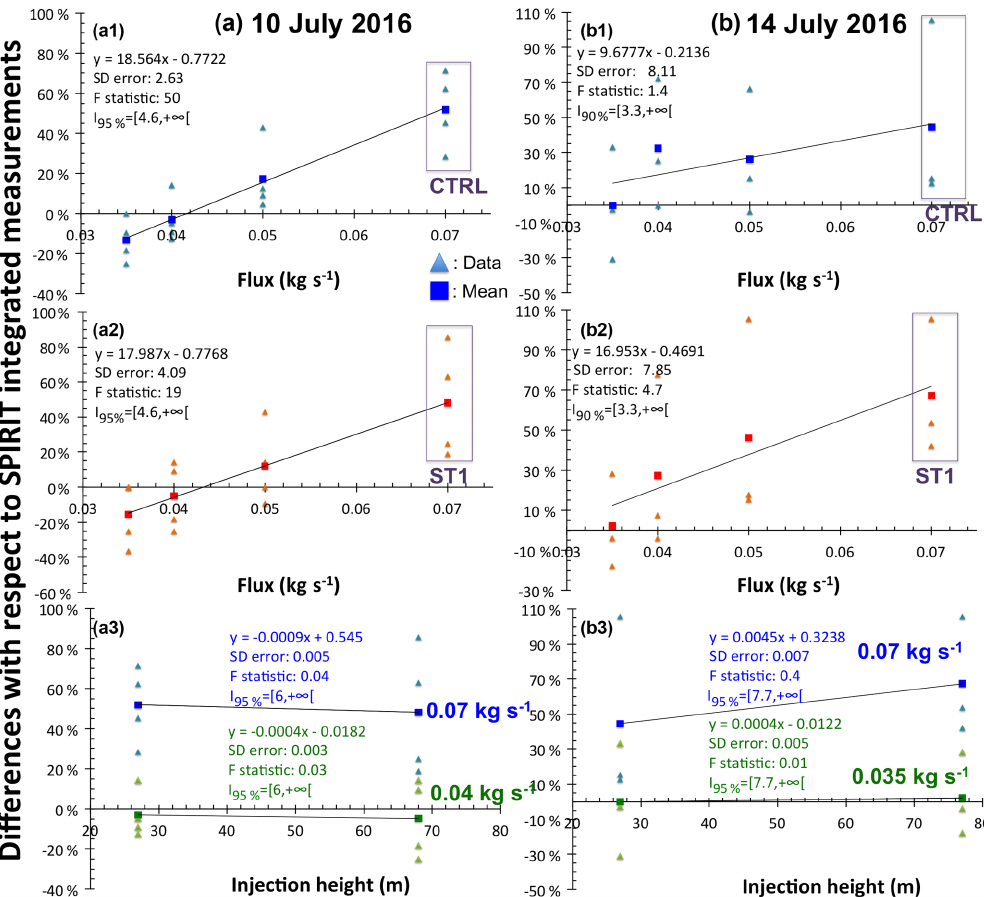
Figure 3. Differences (in %) between FLEXPART simulations and SPIRIT integrated measurements depending on flux or injection height used as input in the model for (a) the flight on 10 July and (b) the flight on 14 July. Panels (a1) and (b1) represent the change in the percentage with the flux by using the injection height from Briggs’ algorithm (1965; blue data; i.e. 27m) and panels (a2) and (b2) with injection height from VDI 3782 (1985; orange data; i.e. 68m – a2 – or 77m – b2 ). Panels (a3) and (b3) represent the change in the percentage with the injection height for the flux from Deetz and Vogel (2017; blue data; 0.07kgs − 1 ) and for the flux used in the sensitivity tests (green data; 0.04kgs − 1 for 10 July in a3 and 0.035kgs − 1 for 14 July in b3 ). For all panels, triangles represent the data for all the peaks measured and squares represent the mean from these data. The slope, standard error values for the slope coefficients, the F statistic and the confidence interval ( I 95% or I 90% only for panel b1 and b2 ) are added for all the